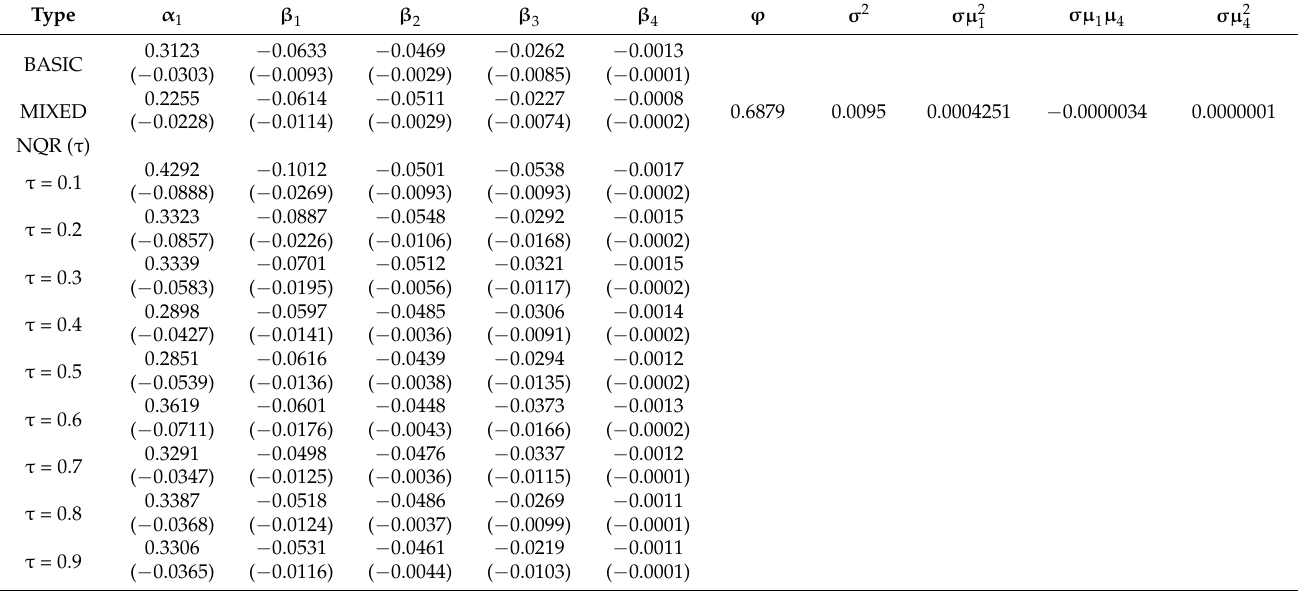
Table A4. Parameter estimates (standard error) of the basic, mixed, and NQR models at different quantiles ( τ ) for LF.